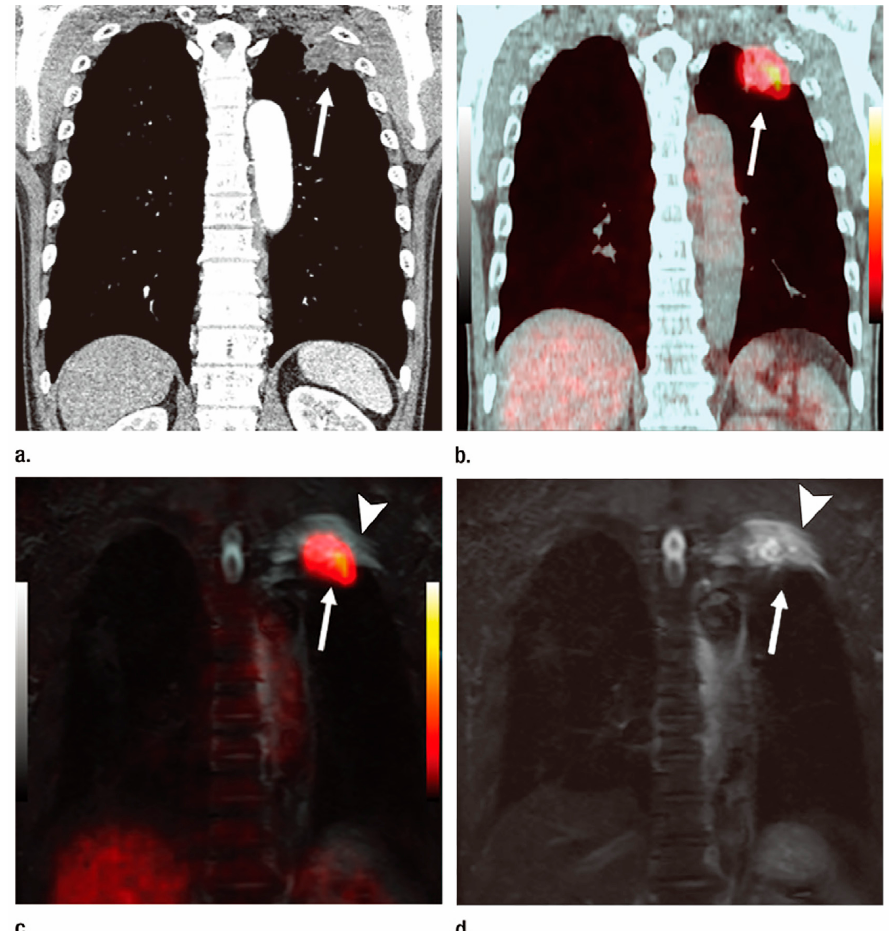
Figure 3. Squamous cell carcinoma diagnosed as T3N0M0 and assessed as stage IIB in a 57-year-old man (permission obtained from reference #59). ( a ) Contrast-enhanced thin-section multiplanar reformatted image with mediastinal window setting shows a mass (arrow) in the left upper lobe. Although the mass is attached to the chest wall, there were no osteoritic changes in the ribs or abnormal enhancement of the chest wall. This patient was diagnosed with T2a and inaccurately evaluated on contrast-enhanced CT imaging. ( b ) Integrated FDG PET/CT scan with mediastinal window setting shows a mass with high FDG uptake (arrow) in the left upper lobe. Although the mass was attached to the chest wall, there were no osteoritic changes in the ribs or abnormal FDG uptake in the chest wall. This patient was diagnosed as T2aN0M0 and stage IB and inaccurately evaluated on PET/CT imaging. ( c ) Co-registered PET/MRI image shows a mass with high FDG uptake (arrow) in the left upper lobe. Although there is FDG uptake within the mass, a high signal intensity area was observed in the adjacent chest wall (arrowhead), and the patient was diagnosed as T3. Assessment of the abnormal signal intensity within the chest wall, aided by whole-body PET/MRI with signal intensity assessment, led to a diagnosis of this patient as T3N0M0 and stage IIB. However, when this abnormal intensity was not included in the evaluation, this patient was diagnosed as T2aN0M0 and stage IB and thus could not be accurately diagnosed by using whole-body PET/MR without signal intensity assessment. ( d ) Whole-body MR images obtained with STIR FASE sequence show a mass (arrow) in the left upper lobe and high signal intensity area within the adjacent chest wall (arrowhead). Based on this abnormal intensity within the chest wall, this patient was accurately diagnosed on whole-body MR imaging as T3N0M0 and stage IIB.